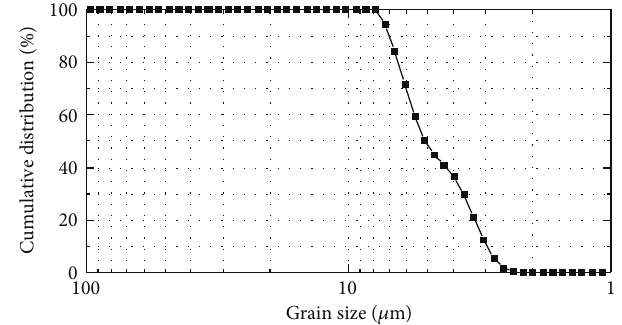
Figure 3: Grain size distribution (GSD) of the selected red mud sample. Table 1: Fundamental properties of the applied geogrid.